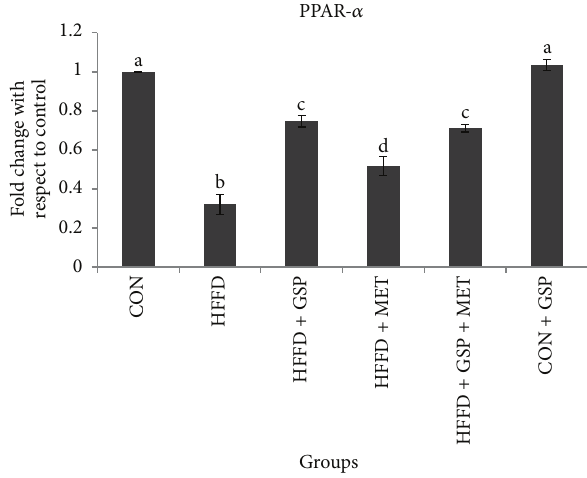
Figure 6: Effect of GSP and MET on mRNA expression of fatty acid oxidation marker PPAR- 𝛼 in liver of experimental animals. Experiments were performed in triplicates, and the data expressed are means ± S.D. of 3 rats from each group. The obtained Ct values of the test gene were normalized with GAPDH and expressed in bars as fold change. Statistical significance between the groups, denotedbydifferentalphabets,wasdeterminedbyone-wayANOVA of significance set at 𝑃 < 0.05